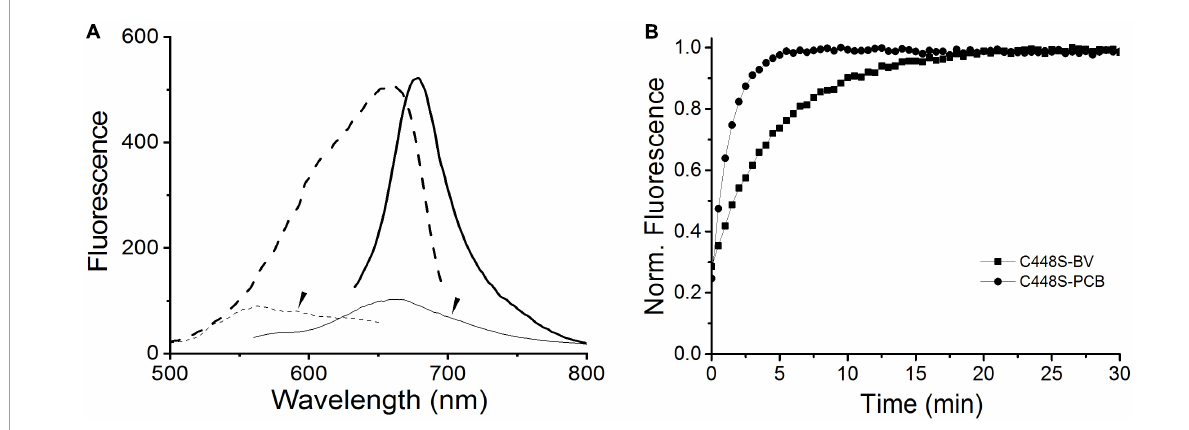
FIGURE3 Fluorescence properties of BV-binding C448S. (A) Fluorescence excitation (dashed lines) and emission (solid lines) spectra of the C448S Pr state (heavy lines) and the C448S Po state (thin lines indicated by the arrow). (B) Normalized fluorescence intensity of the biliprotein (C448S-BV) at 680 nm during dark reversion. C448S-PCB represents the PCB-binding C448S as a control. The half-lives calculated by exponential fitting are 3.2 min for C448S-BV and 15.3 s for